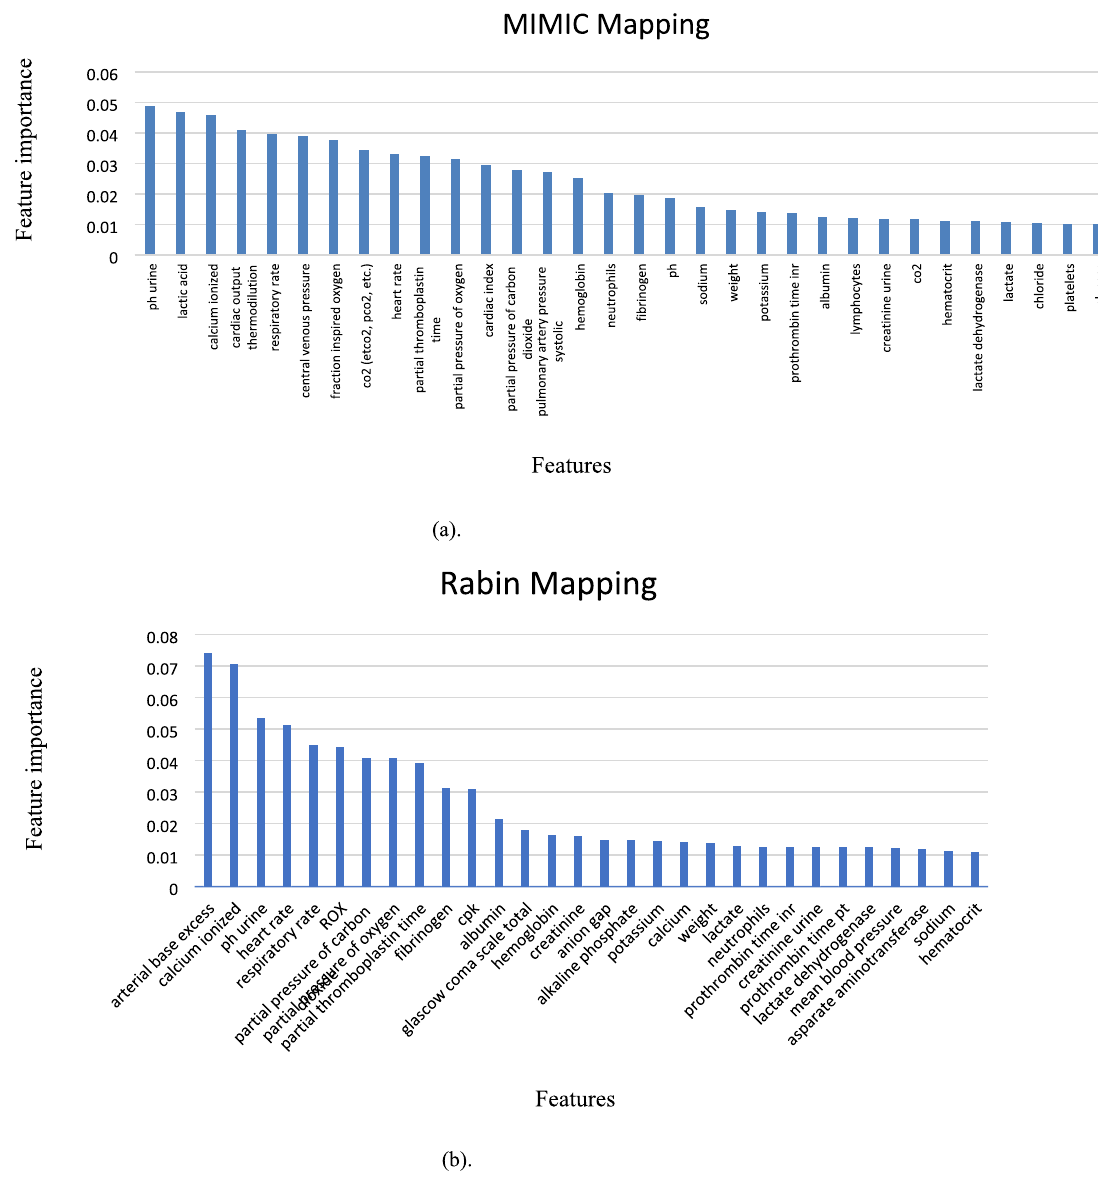
Figure 3. Feature importance in different feature mappings. a. MIMIC-III mapping, b. Rabin mapping. The relative contribution to the predictive model of the most important features for each database is shown. ROX index was defined as the ratio of pulse oximetry/fraction of inspired oxygen to respiratory rate 19 . Feature importance in Gradient Boosting Trees (XGBoost is one of them) is calculated for a single decision tree by the amount that each attribute split point improves the performance measure, weighted by the number of observations the node is responsible for. The feature importance is then averaged across all the decision trees within the model 20